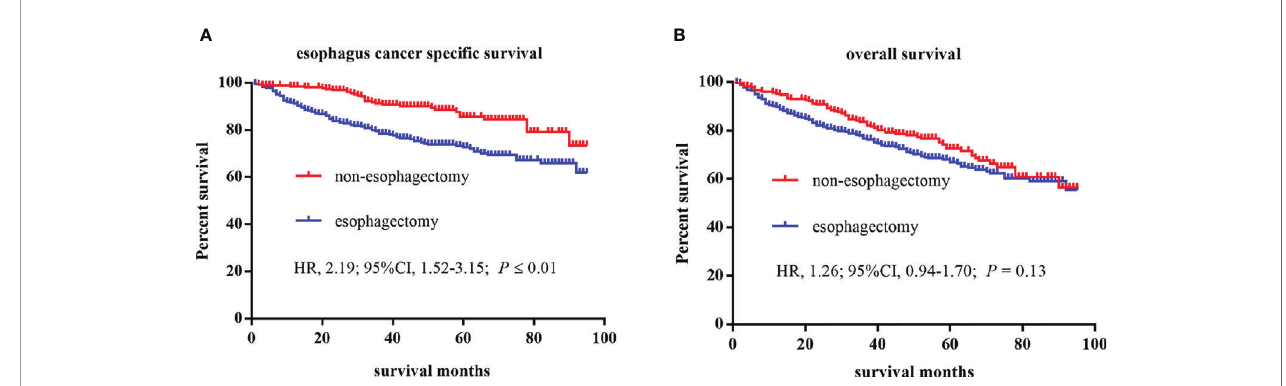
FIGURE 1 | Kaplan – Meier curves of survival estimates for T1 stage esophagus cancer patients who underwent non-esophagectomy and esophagectomy. (A) , esophagus cancer speci fi c survival. (B) , overall survival. HR, hazard ratio; CI, con fi dence